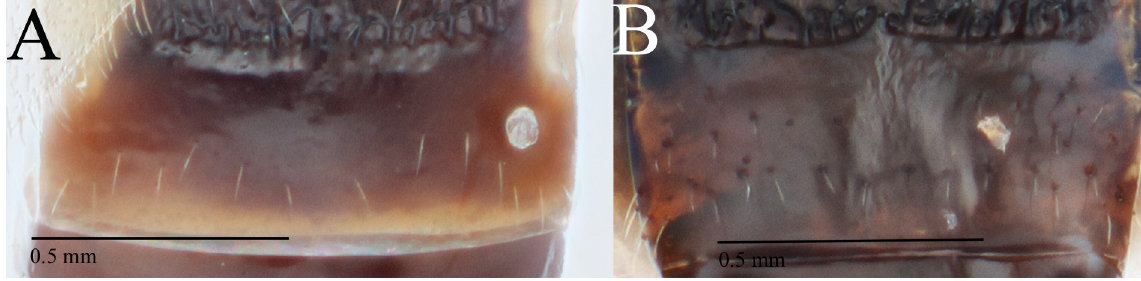
Fig. 4. A . Cotesia ruficrus (Haliday, 1834), T3 (ANIC 32 130230). B . Cotesia vestalis (Haliday, 1834), T3